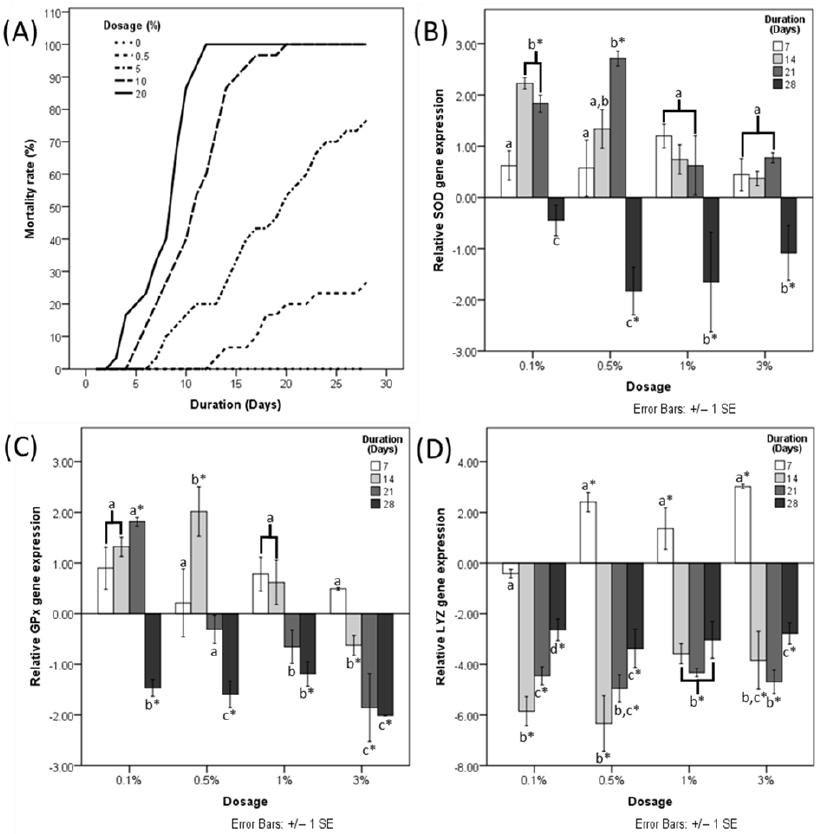
Figure 1. ( A ) Mortality rate of shrimp fed with different doses of HDPE microplastic. Fold change of ( B ) SOD, ( C ) GPx, and ( D ) LYZ gene expression normalized to a negative control at four different time points. Different letters (a, b, and c) above bars belonging to the same data series indicate significant differences between sampling times for each treatment. Asterisk indicates a significant difference from the negative control. p < 0.05.